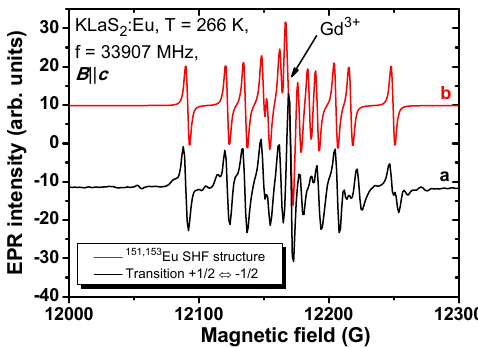
Figure 11. Experimental ( a ) and simulated ( b ) EPR spectra of the Eu 2+ centra transition +1/2 − 1/2 showing hyperfine structure from 151,153 Eu isotopes.